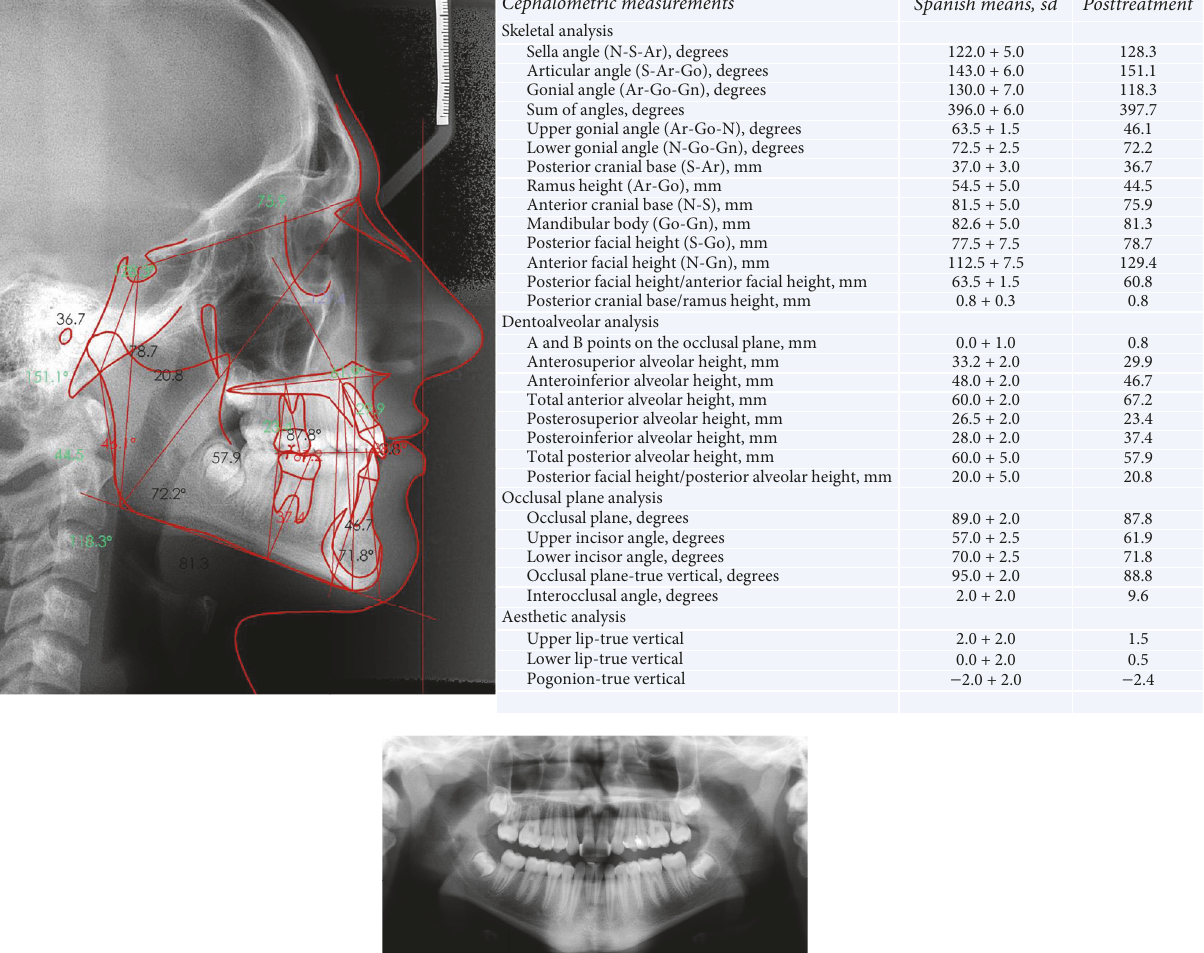
Figure 6: Final panoramic radiograph and lateral radiographic and cephalometric measurements.